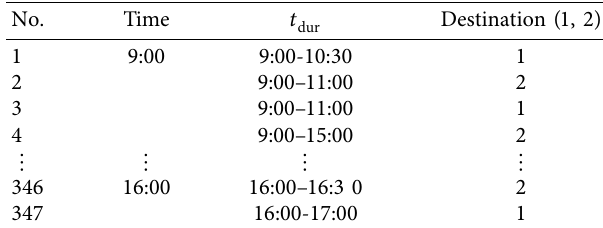
Table 2: Parking demands.